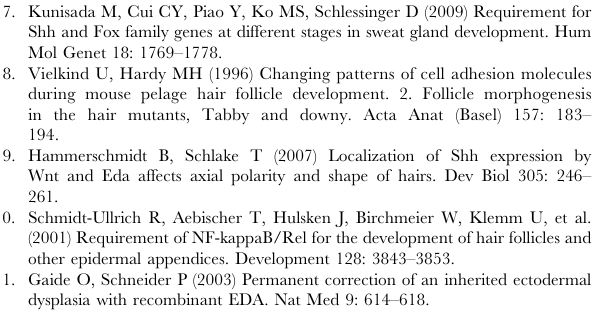
Table S1 Expression levels of Wnt pathway genes in Ta and TaDk4TG skin at